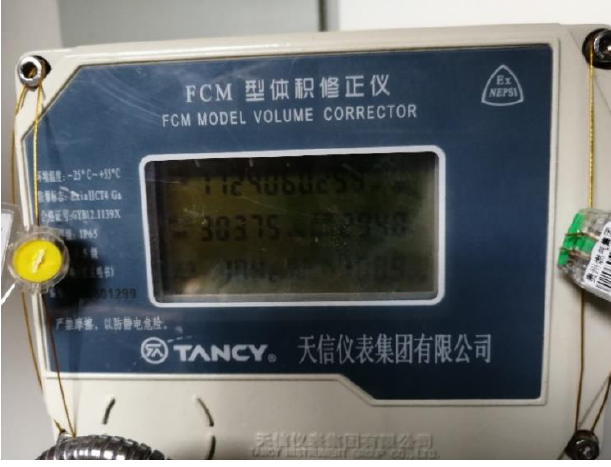
Figure 2. Gas use record of E2 station.